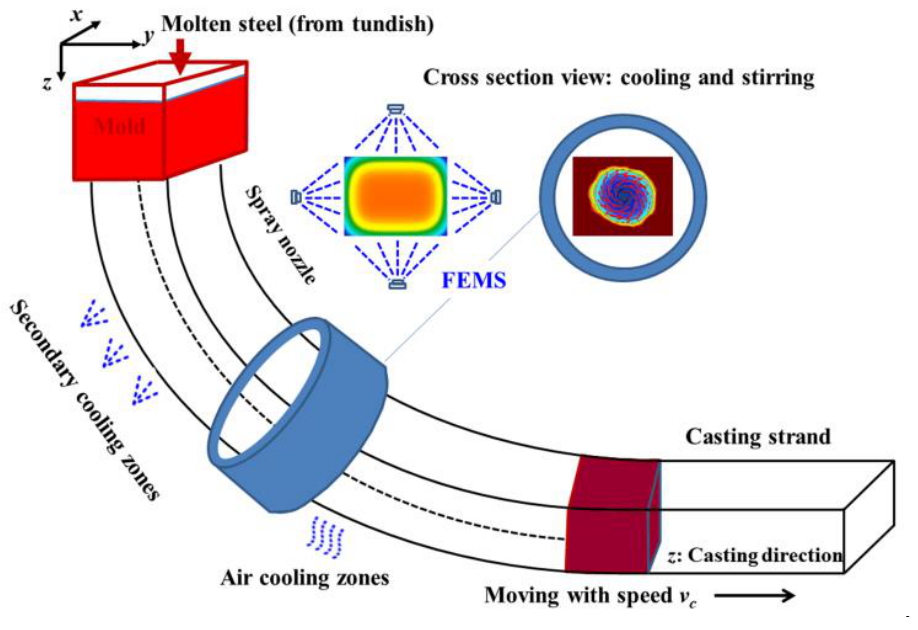
Figure 1. Continuous casting process.